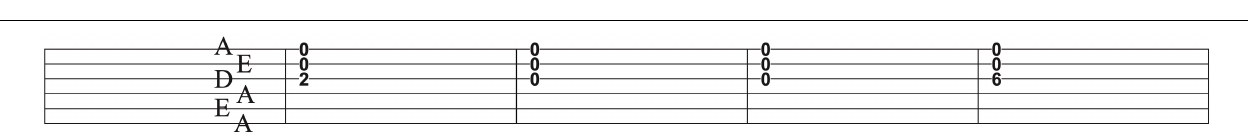
FIGURE 5 | Chosen notes and strings for drone-based